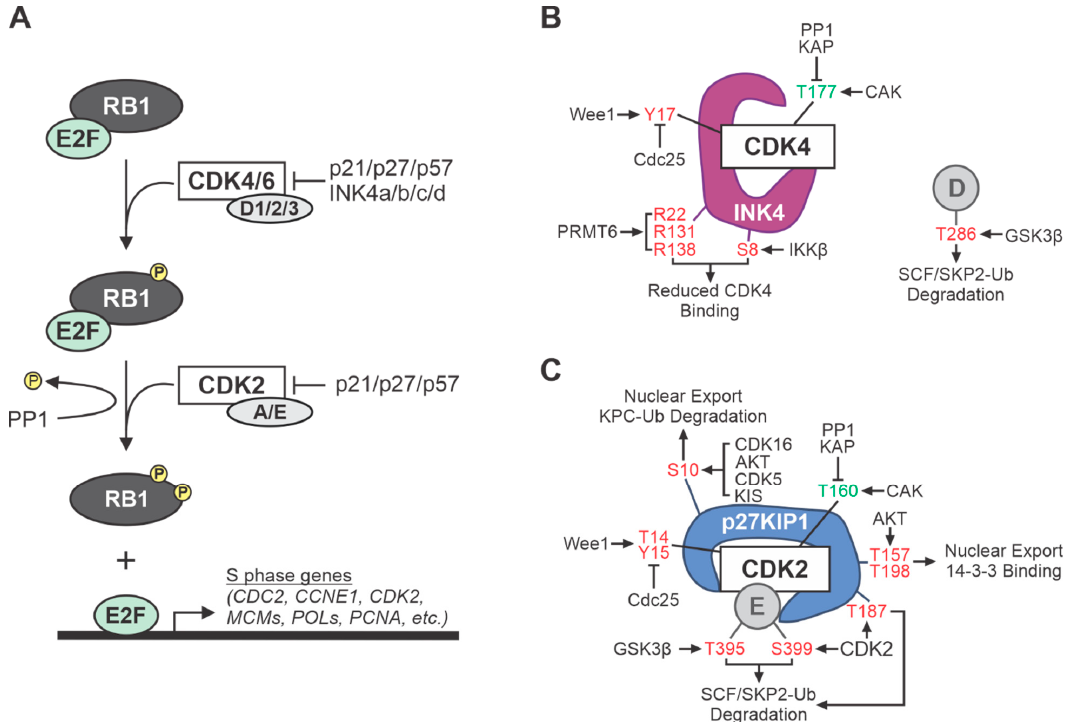
Figure 1. Overview of cell cycle cyclin-dependent kinase (CDK)-related signaling and regulation. (A) Several cell cycle CDKs inactivate RB1, promoting progression into S phase. RB1 binds and sequesters E2F transcription factors throughout G1. CDK4/6-cyclin D complexes phosphorylate RB1, priming it for subsequent phosphorylation by CDK2-cyclin A/E. Hyper-phosphorylation of RB1 causes release of E2F, enabling transcription of genes necessary for S phase and DNA synthesis. Two families of CDK inhibitors, CIP/KIP (p21/p27/p57) and INK4 (a/b/c/d), prevent RB1 phosphorylation; thereby halting cell cycle progression. (B) INK4 family members specifically inhibit CDK4 and CDK6 activity by preventing CDK-cyclin D complex formation. (C) CIP/KIP family members inhibit the various CDKs by binding the CDK-cyclin holoenzymes. Sites of post-translational modification in ( B ) CDK4, INK4, and cyclin D or (C) CDK2, p27KIP1, cyclin E that either promote (green) or inhibit (red) the